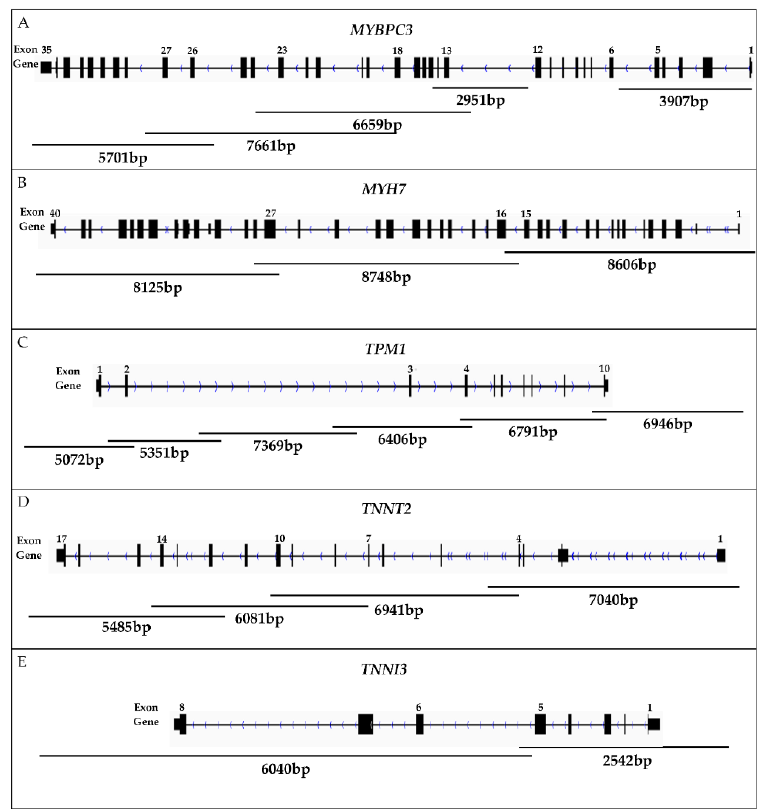
Figure 1. The structure of five sarcomeric protein genes. Primers for long-range PCR employed in this study are illustrated by lines, each annotated with PCR product size (bp). ( A ) The MYBPC3 gene was amplified in five fragments covering the promoter region and the coding sequences of exons 1–5 and 13–35. ( B ) The MYH7 gene, including its promoter, was amplified in three fragments. ( C ) TPM1 , including its promoter, was amplified in six fragments. ( D ) TNNT2 , including its promoter, was amplified in four fragments. ( E ) The TNNI3 gene, including its promoter, was amplified in two